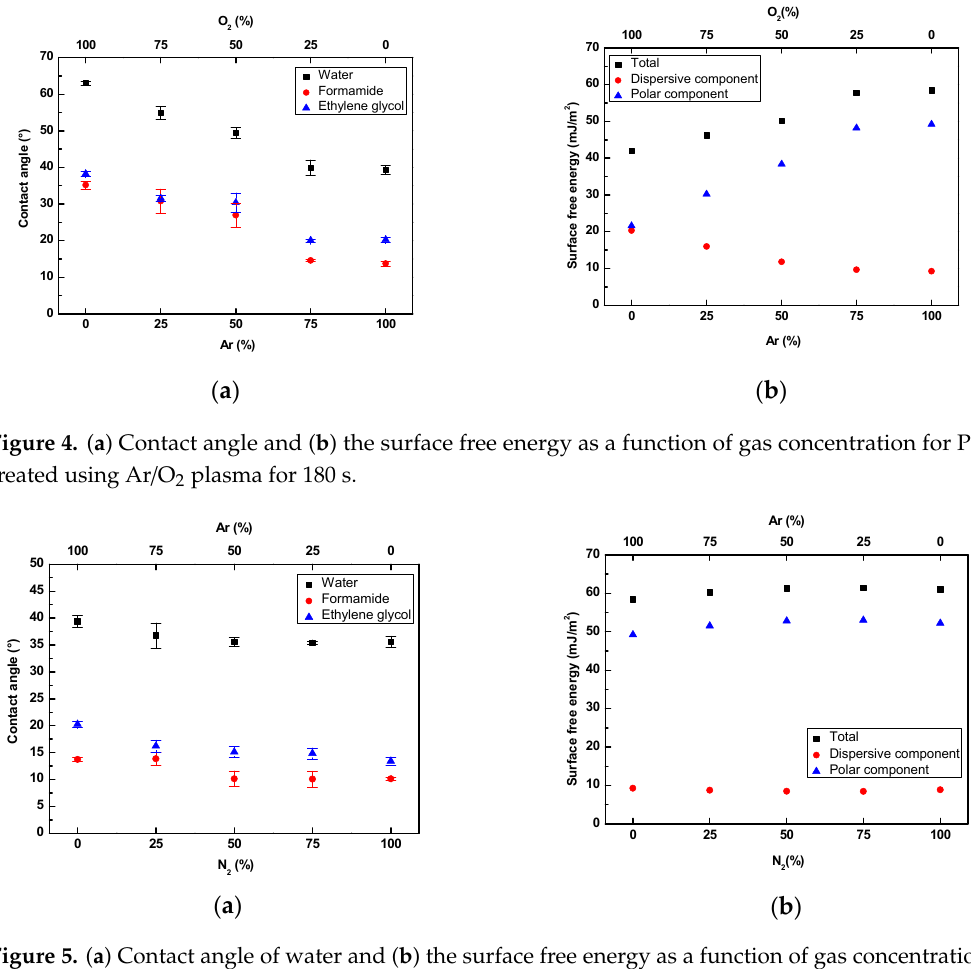
Figure 3. ( a ) Contact angle of water and ( b ) the surface free energy as a function of gas concentration for PU treated using N 2 /O 2 plasma for 180 s.